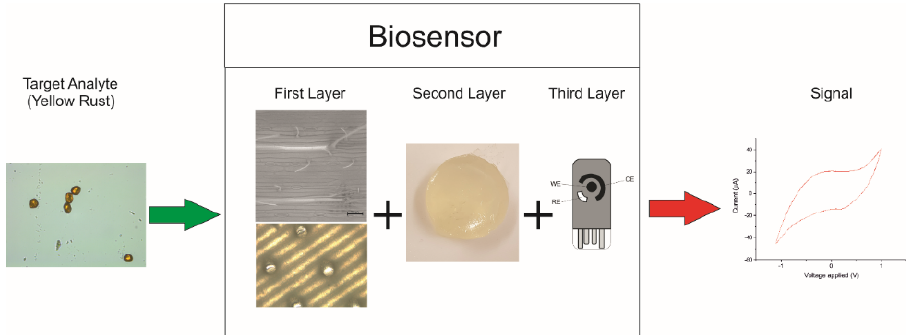
Figure 3. Operational rationale of proposed yellow rust biosensor. The signal can be obtained directly as a CV curve indicating the presence of glucose and therefore yellow rust.